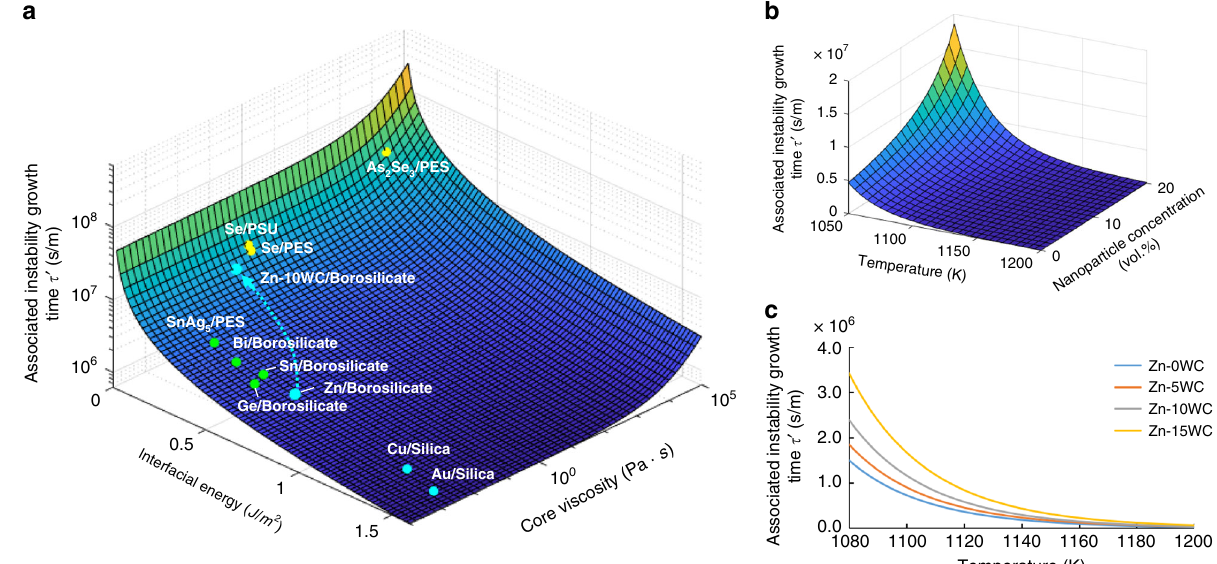
Fig. 1 Theoretical analysis of fl uid instability in thermal drawing in multiple systems. a Associated instability growth time vs. core material interfacial energy and viscosity under the condition that the cladding viscosity is 10 6 Pa·s. Data adapted from the literature are speci fi ed in Supplementary Table 2. Zinc-WC/borosilicate has been demonstrated to enhance the associated instability growth time by adding nanoparticles to the core material for interfacial energy reduction and viscosity enhancement, as indicated by the cyan arrow. High-melting-temperature metals (Zn, Cu, Au), low-melting-temperature metals (SnAg 5 , Sn, Bi, Ge), and semiconductors (Se, As 2 Se 3 ) have been marked on the graph, indicated by cyan, green, and yellow dots, respectively. b Theoretical associated instability growth time of Zn-WC nanocomposite as the core material in borosilicate glass cladding, concerning temperature and nanoparticle concentration. c The associated instability growth time vs. drawing temperature for Zn-WC/borosilicate system. At a typical drawing temperature of 1080 – 1100 K, 15 vol.% nanoparticles ef fi ciently enable the fl uid instability